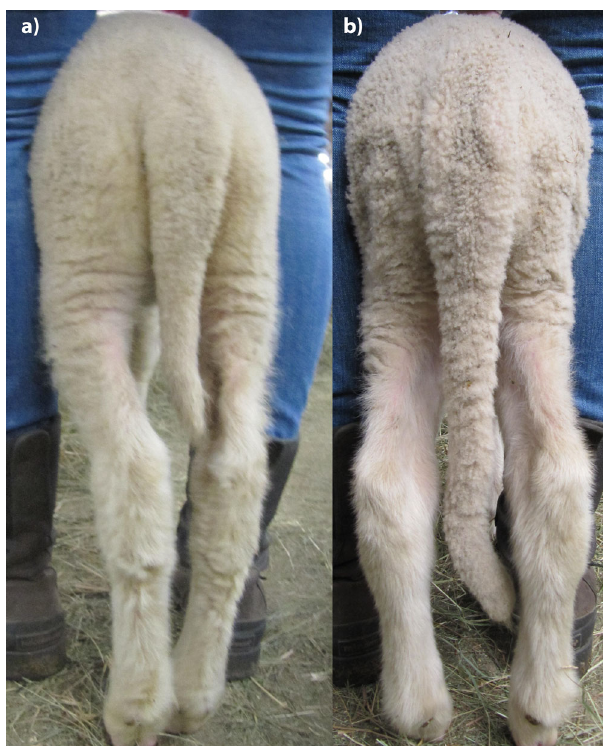
Fig. 4 Natural tail length variation in Merinolandschaf. Photo of a short- tailed ( a ) and a long-tailed ( b ) lamb, both lambs were ~5 weeks old and not